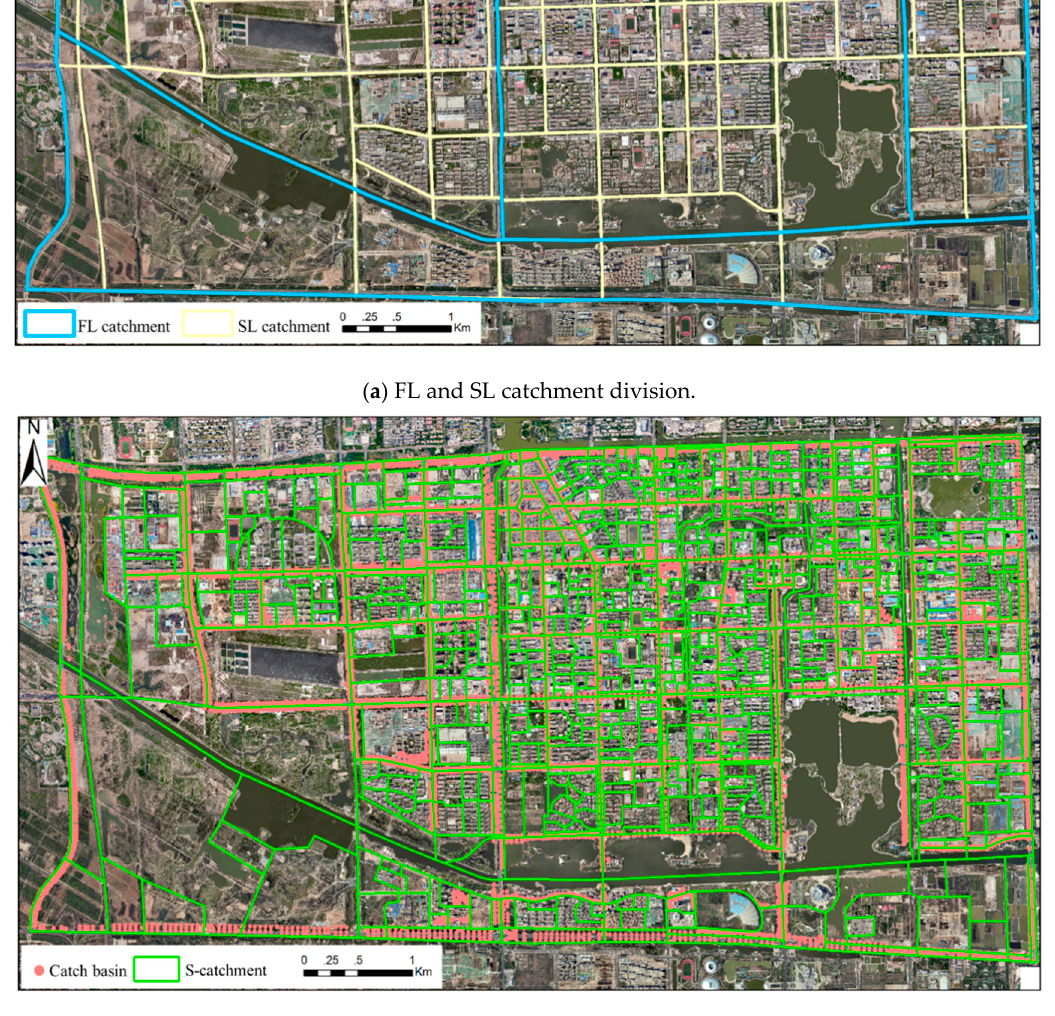
Figure 12. Partitioning of the catchment areas in the study area, ( a ) denotes the FL and SL catchment division result, ( b ) denotes the S-catchment division result.